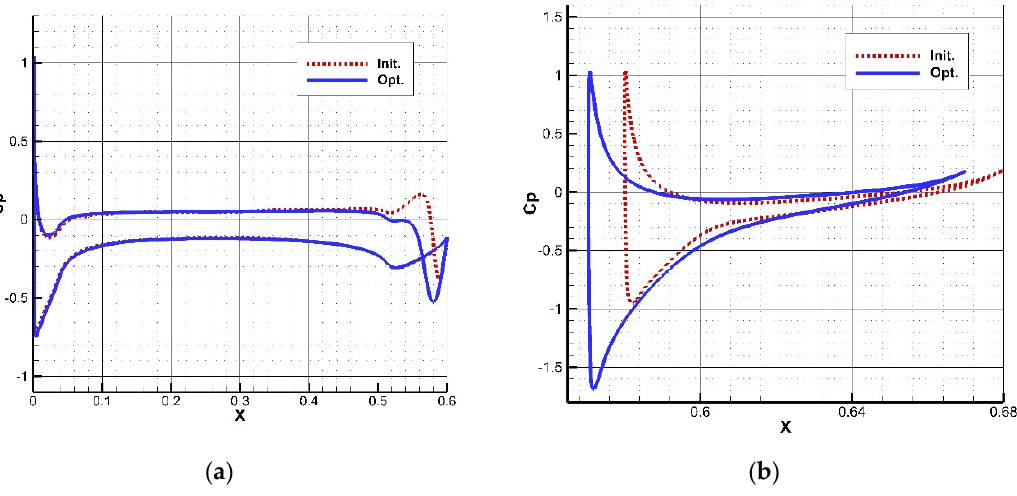
Figure 22. Comparison between initial shape and optimal shape.